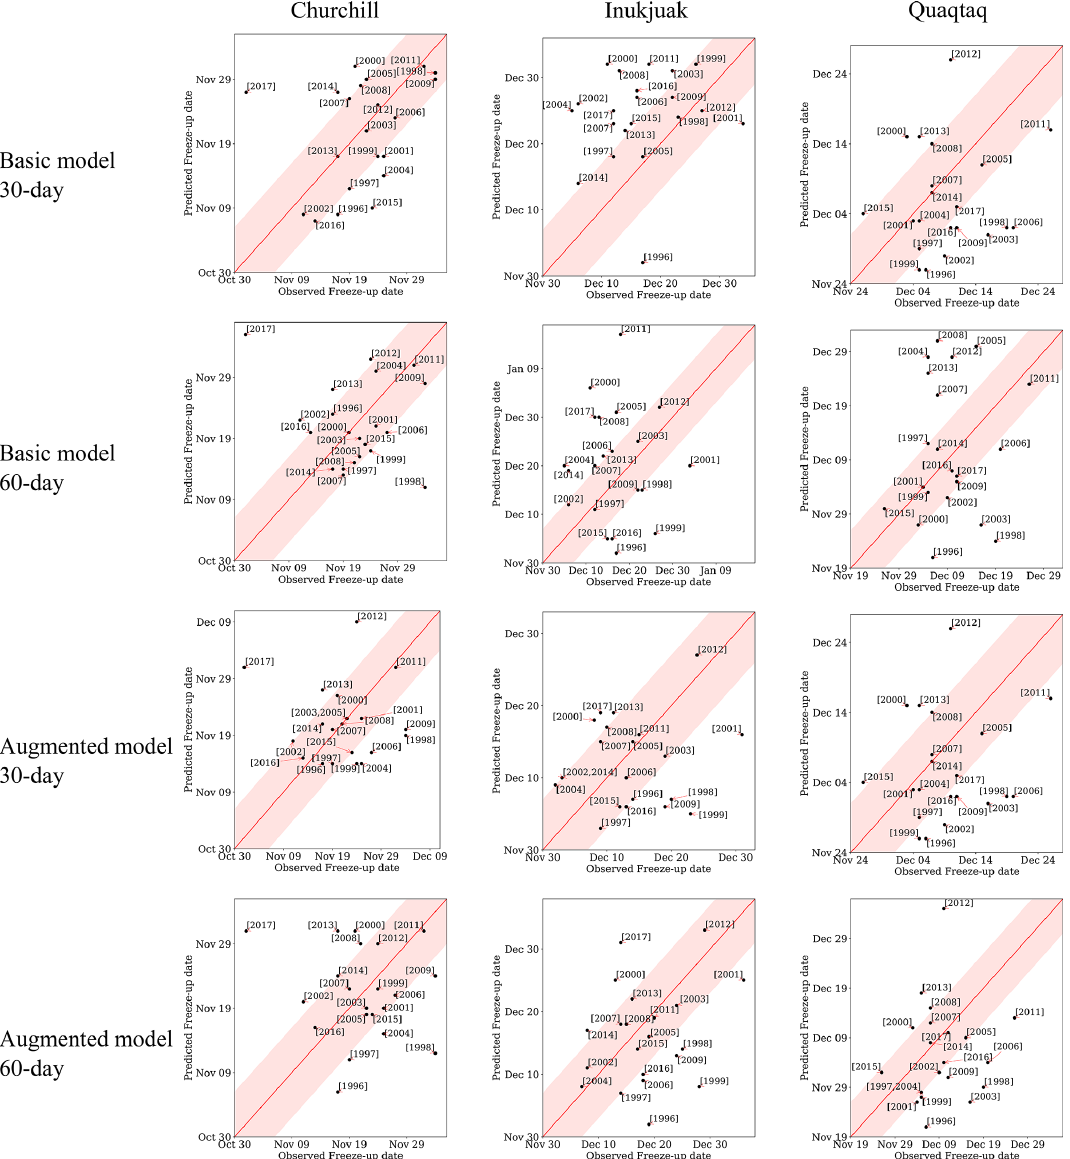
Figure 11. Comparison between forecast and observed freeze-up dates at pixels located in the vicinity of ports in the study region for 30 and 60 lead days. Each dot represents 1 year. The red line represents perfect predictions, and the pink area represents ± 7d of the red line, which is commonly assumed to be an acceptable error